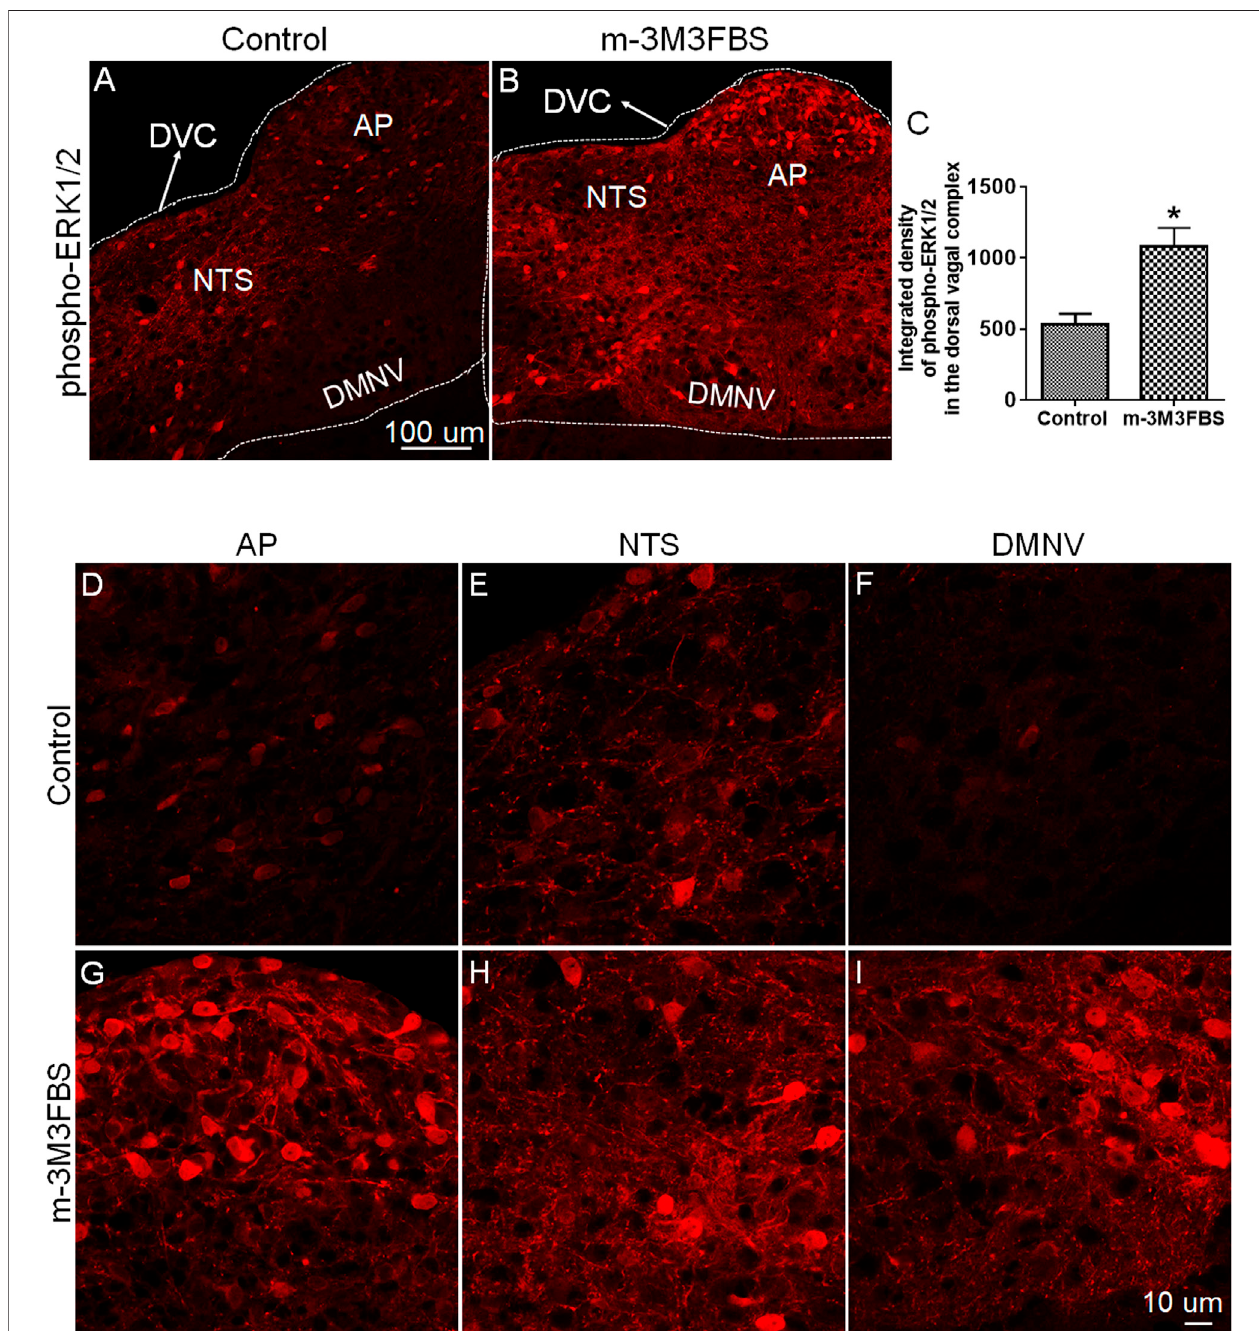
FIGURE3| ImmunohistochemicalanalysisofERK1/2phosphorylationfollowingm-3M3FBS-inducedemesis. Leastshrews weresacri fi ced60 minafter vehicleor m-3M3FBS administration (50 mg/kg, i. p.) ( n (cid:1) 3 shrews per group). Brainstem sections (20 μ m) were stained with rabbit anti-phospho-ERK1/2 antibody and Alexa Fluor594donkeyanti-rabbitsecondaryantibody. (A,B) Representativeimagesshowthatcomparedtothevehicle-treatedcontrolgroup,m-3M3FBSincreasedERK1/2 phosphorylationinthebrainstemdorsalvagalcomplex.Scalebar,100 μ m. (C) StatisticalanalysisofintegrateddensityofERK1/2phosphorylationinthebrainstem dorsal vagal complex. * p < 0.05 vs. Control, Unpaired t -test. (D – I) Representative magni fi ed images show m-3M3FBS increased ERK1/2 phosphorylation in the emetic nucleilocatedinthedorsalvagalcomplex,areapostrema(AP),thenucleustractussolitarius(NTS) andthedorsalmotornucleus ofthevagus(DMNV).Scalebar,10 μ m.